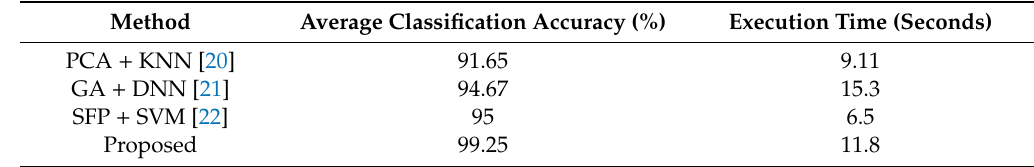
Table 3. Comparison results of di ff erent